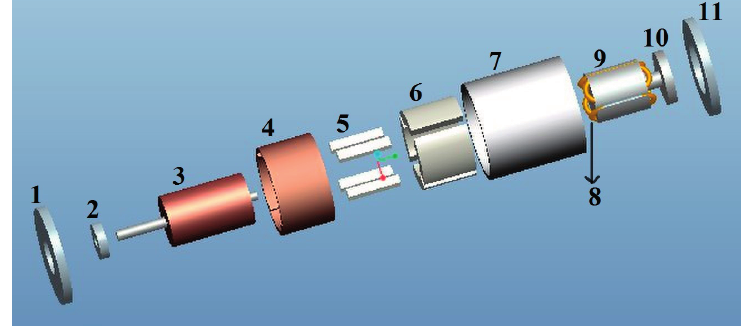
Figure 1. 3D assembly diagram of the angular acceleration